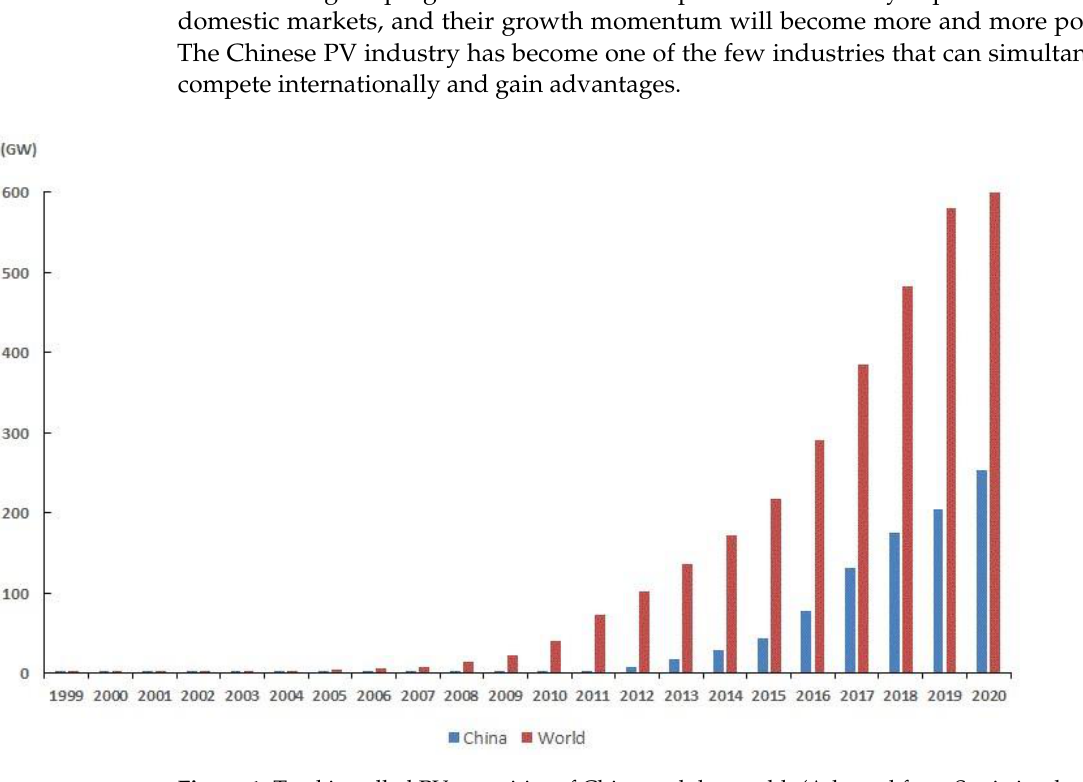
Figure 1. Total installed PV capacities of China and the world. (Adapted from Statistics database of the Development Research Center of the State Council of the People’s Republic of China